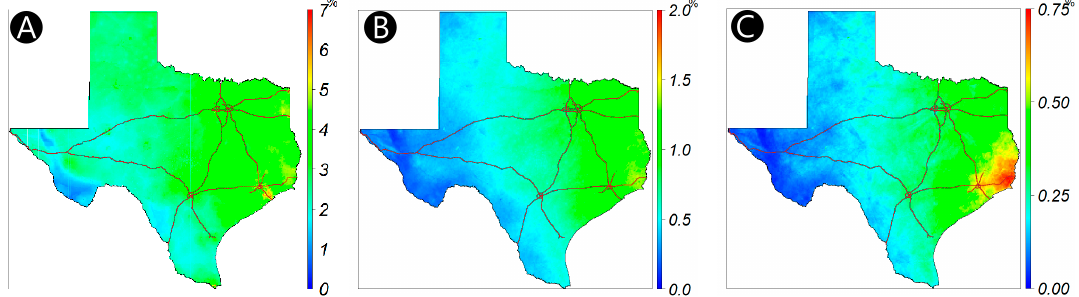
Figure 4. Spatial distribution of the average annual frequency of hourly precipitation for different intensities ( A ) light; ( B ) moderate intensity; ( C ) heavy.